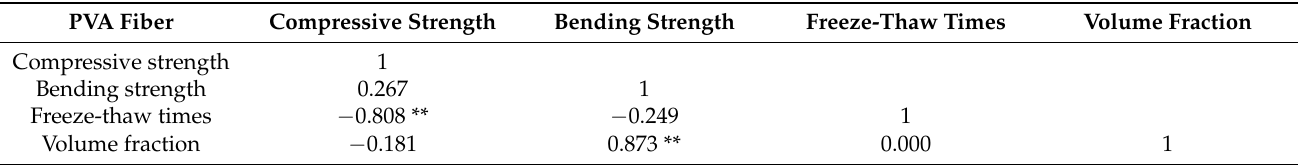
Table 11. Pearson correlation coefficient of PVA fiber cement-based